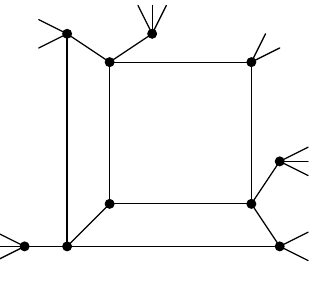
Fig. 2: The neighborhood of vertices v 0 , v 1 , v 2 , and v 3